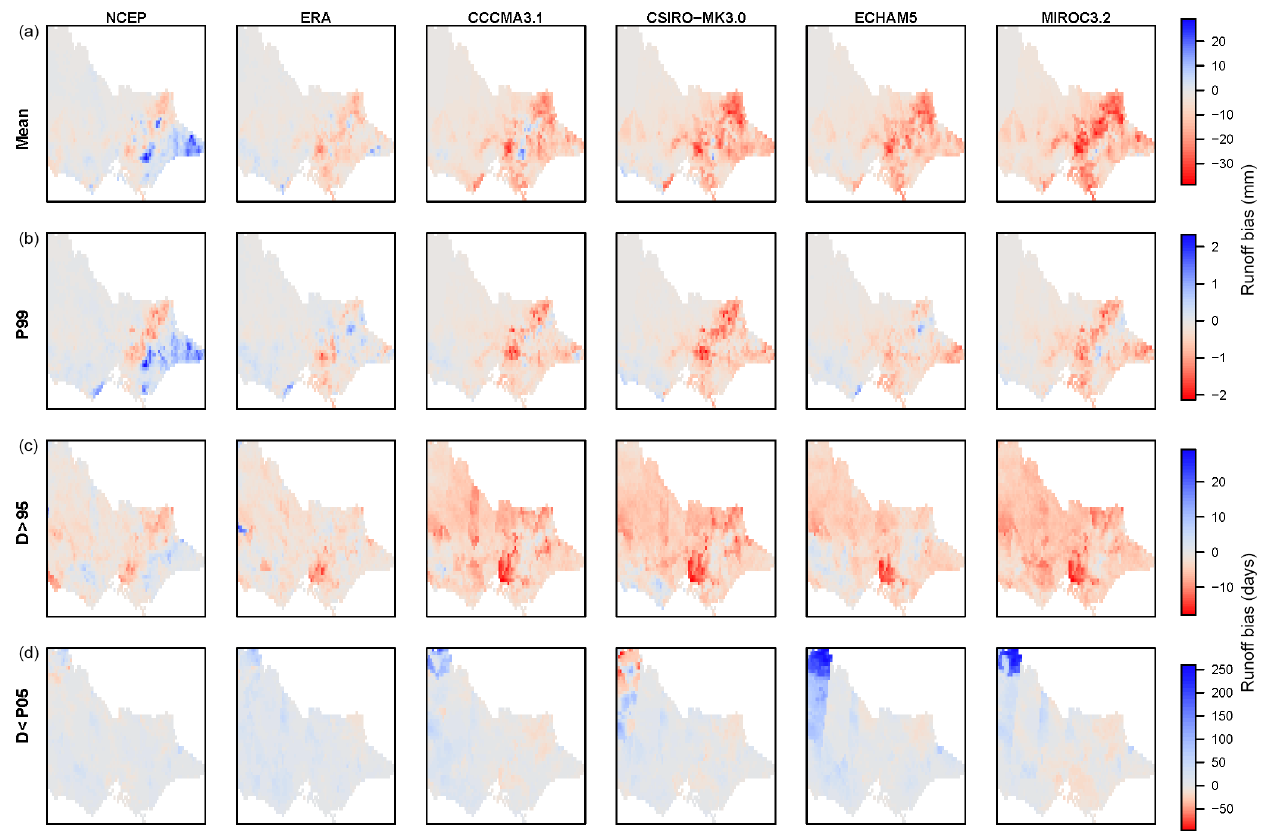
Figure 3. Historical (1990–2009) runoff simulation bias (i.e. runoff using WRF-BC rainfall minus runoff using AWAP rainfall) for (a) mean annual runoff (mm), (b) daily 99th-percentile runoff (mm), (c) number of days exceeding AWAP 95th percentile and (d) number of days below AWAP 10th percentile. Columns (left to right) are using WRF-BC rainfall forced by two reanalyses (NNR and ERAI) and then four GCMs (CCCMA3.1, CSIRO-MK3.0, ECHAM5 and